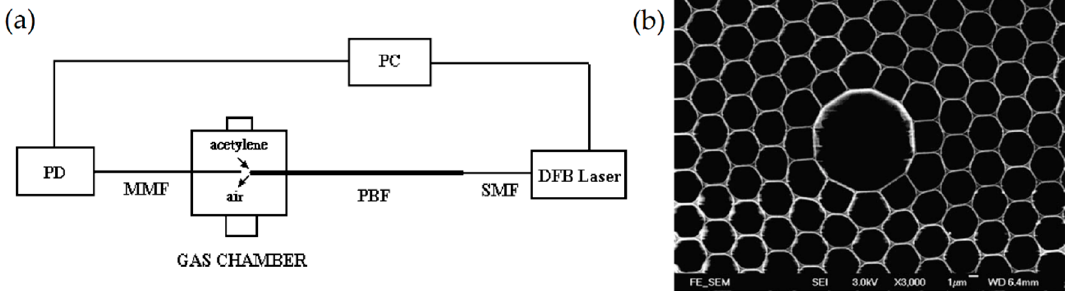
Figure 7. ( a ) Schematic diagram of the experimental setup used in [32]; ( b ) microscopic picture of the HCF used in this work (the fiber was obtained from Blazephotonic, UK). Reprinted from [32], with permission from Elsevier.